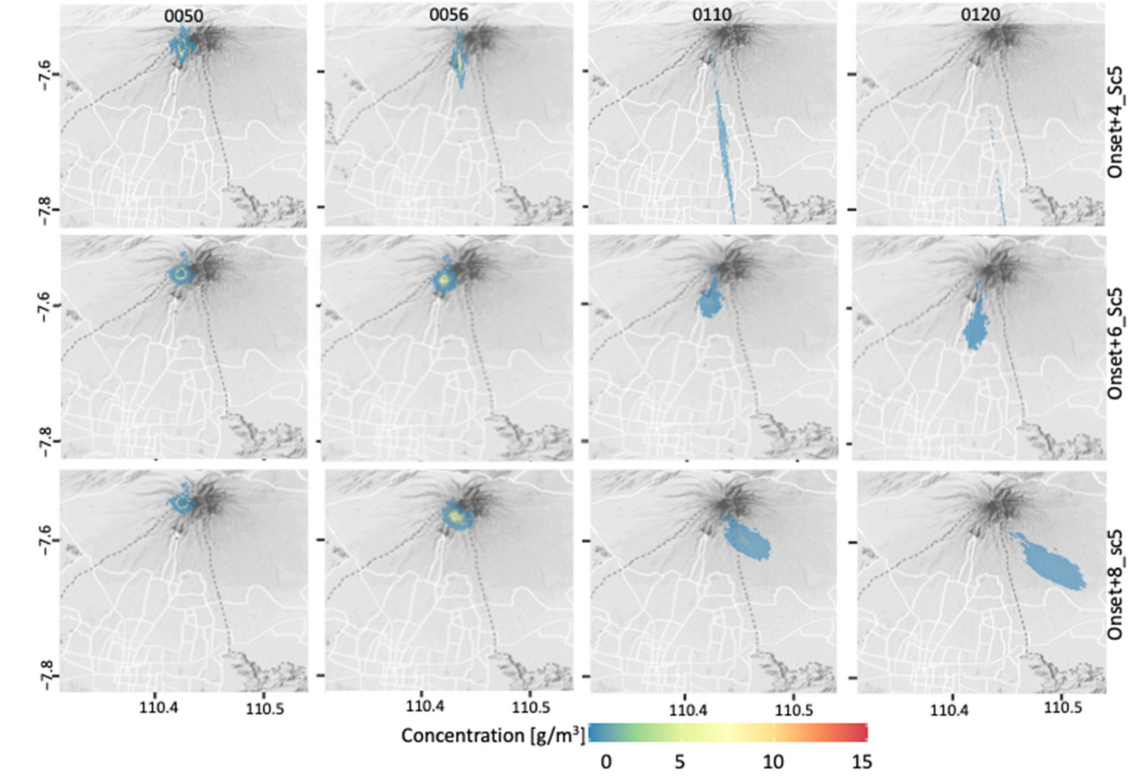
Figure A3. Some examples of the ensemble members (row) at different time step output (column). Presented is the nowcasting of M05. Each ensemble member was named based on the initial condition: onset+ i _Sc j , where i and j represent the time in minutes and advection scenario (Table 3), respectively. In each image, the x -axis is longitude and y -axis is latitude.